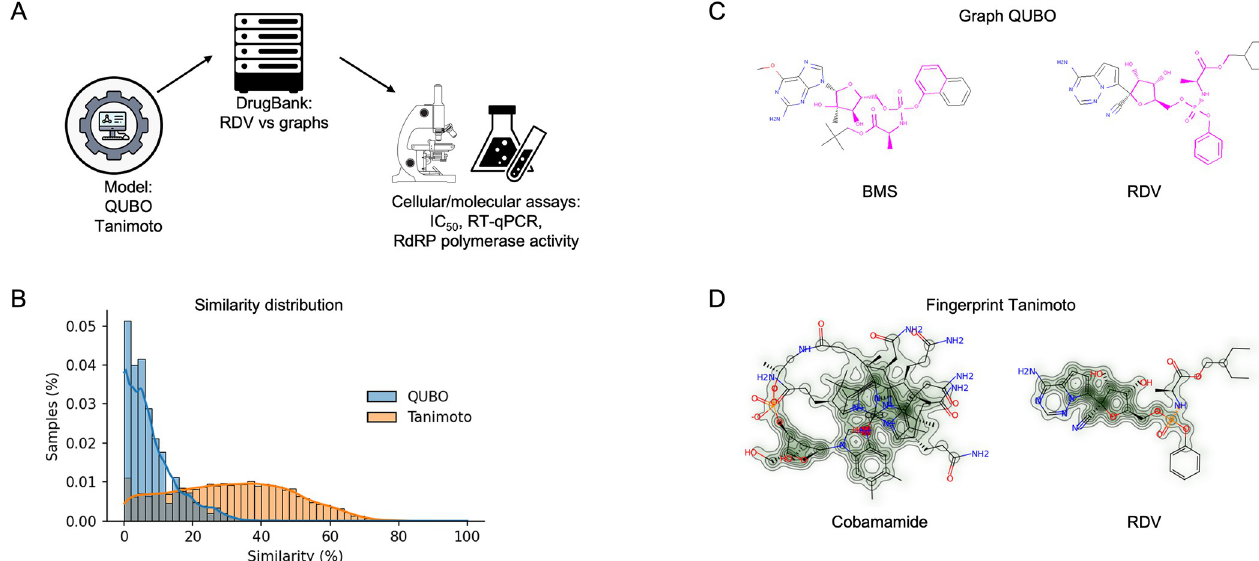
Fig 1. Molecular modelling. (A) pipeline employed in our project. RDV was firstly modelled as a graph and then screened against the DrugBank dataset. (B) Comparison of samples from the DrugBank predicted as similar to RDV by QUBO (blue) and Tanimoto (orange) models. (C) Graphic representation of BMS- 986094 (BMS, left) and RDV (right) similarity according to QUBO. The magenta color represents the similar elements between the two molecules, including atoms as well as bonds, while the rest of the representation is the non-similar elements. (D) Graphic representation of similarity for cobamamide (left) and RDV (right) generated by RDkit. The increasing green color represents increased similarity between